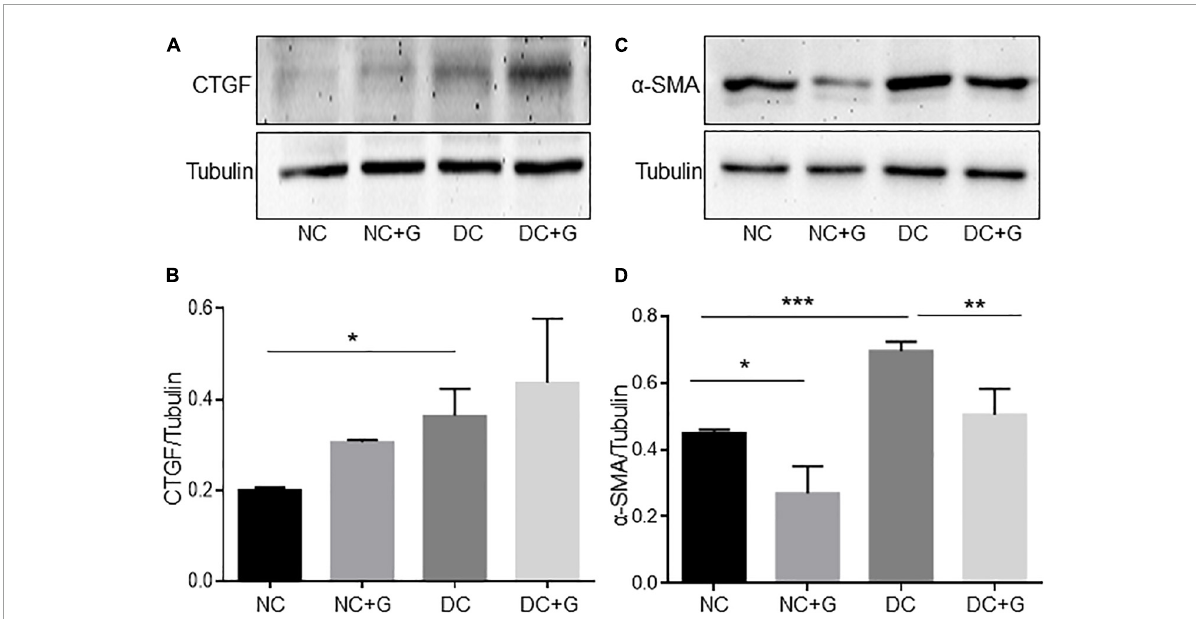
FIGURE4 Glucosamine lowers protein expression of α -SMA in diabetic kidneys. Expression of CTGF and α -SMA in the renal cortex was assessed by Western blot (A,C) and quantified using ImageJ (B , D) . γ -tubulin served as loading control. Data are shown in mean ± SEM. n = 4. * p < 0.05, ** p < 0.01, *** p <